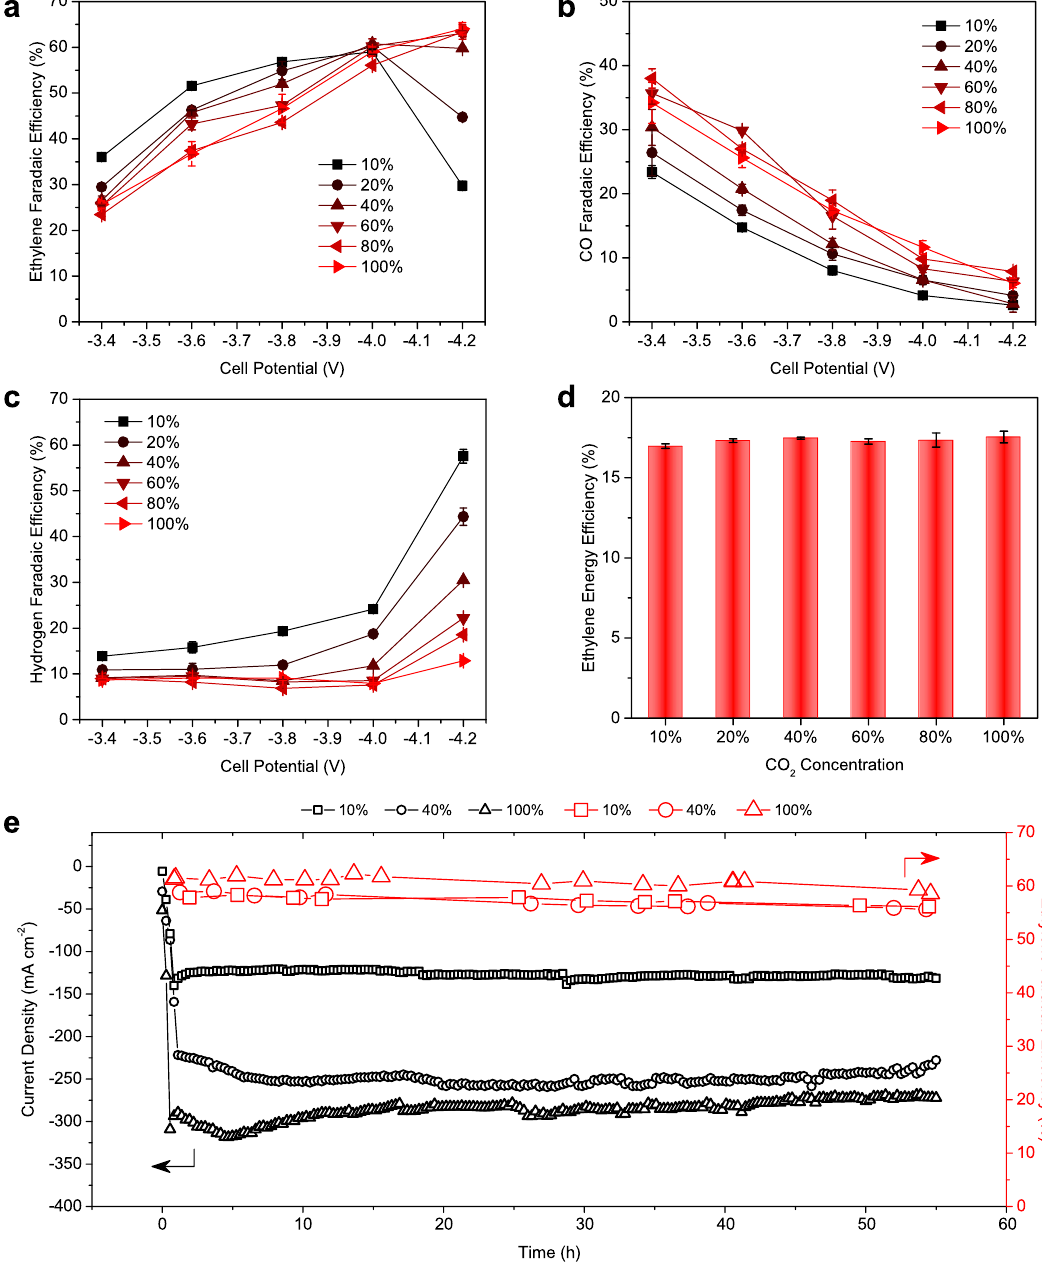
concentration on FE ethylene ( a ), FE CO ( b ), FE hydrogen ( c ), and EE ethylene ( d ). Error bars are means ± SD ( n = 3 replicates). e Extended operational stability of the MEA equipped with the Cu-SiO x under CO 2 concentration of 10% at − 3.8 V, 40% at − 4.0 V, and 100% at − 4.1